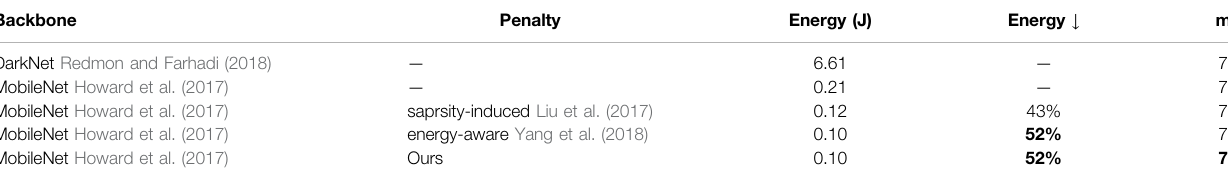
TABLE 1 | Object detection performance on PASCAL VOC. “ Penalty ” denotes the penalty item that we added for training loss. “ Energy ” denotes the energy cost for detecting one image. “ Energy ↓ ” denotes the energy saved comparing to original network whose backbone is MobileNet; “ mAP ” is a common indicator evaluating the performance of detection